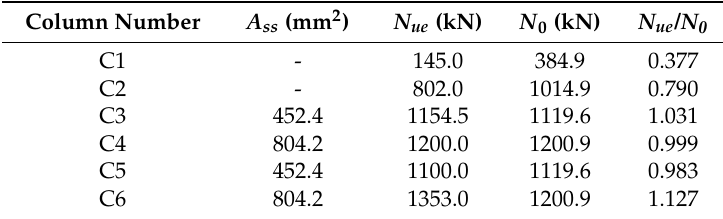
Table 4. Comparison of axial bearing capacity of